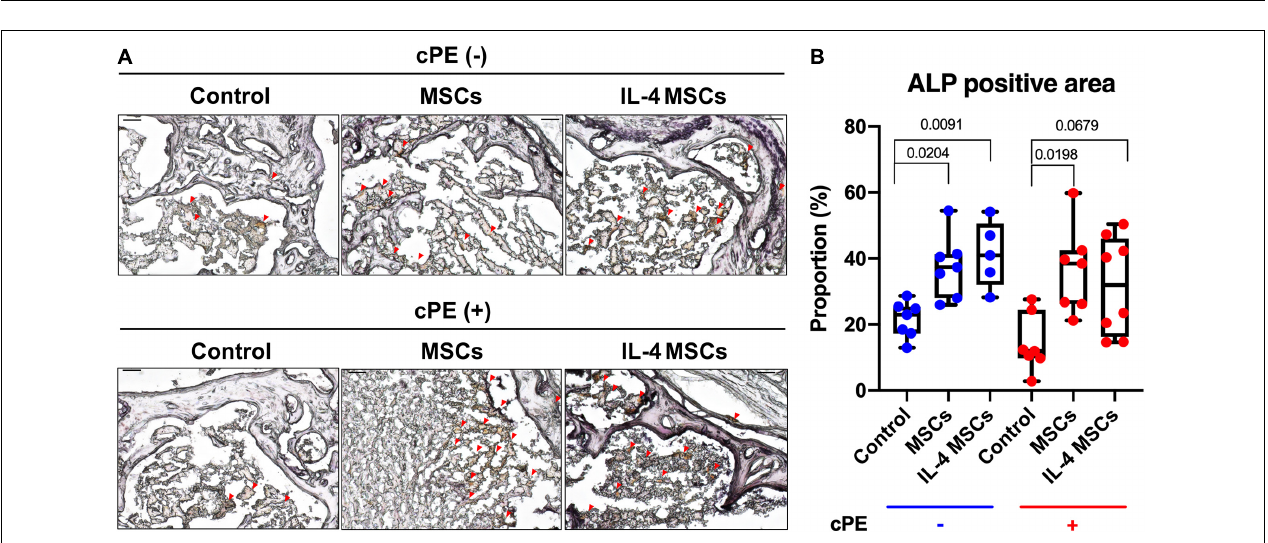
FIGURE 5 | TRAP staining of all the groups. (A) Representative images of TRAP staining, red arrows point the TRAP positive cells. (B) Quantitative analysis of TRAP positive cells number. (cPE- control group: n = 7; cPE- MSCs group: n = 8; cPE- IL-4 MSCs group: n = 9; cPE + control group: n = 7; cPE + MSCs group: n = 8; cPE + IL-4 MSCs group: n = 9).